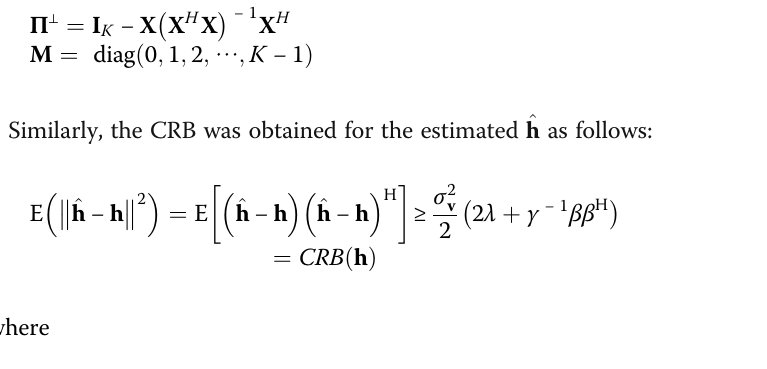
Table 4 The parameter μ for other various mobile speeds Mobile speed v (km/h) Parameter